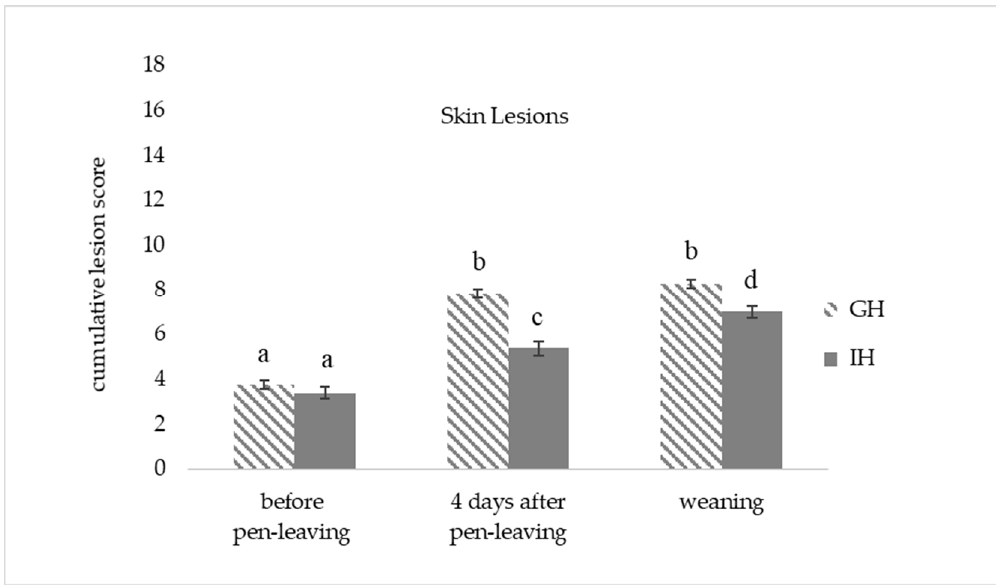
Figure 3. Least-Square-Means and standard errors (±SE) of the cumulative lesion score for the piglets during the suckling period (before pen-leaving = 1st week; 4 days after pen leaving = 2nd/3rd week; weaning = 5th week of life) for GH (group housing n = 274 piglets) and IH (individual housing n = 126 piglets). Significant differences are indicated by different letters ( p < 0.05).